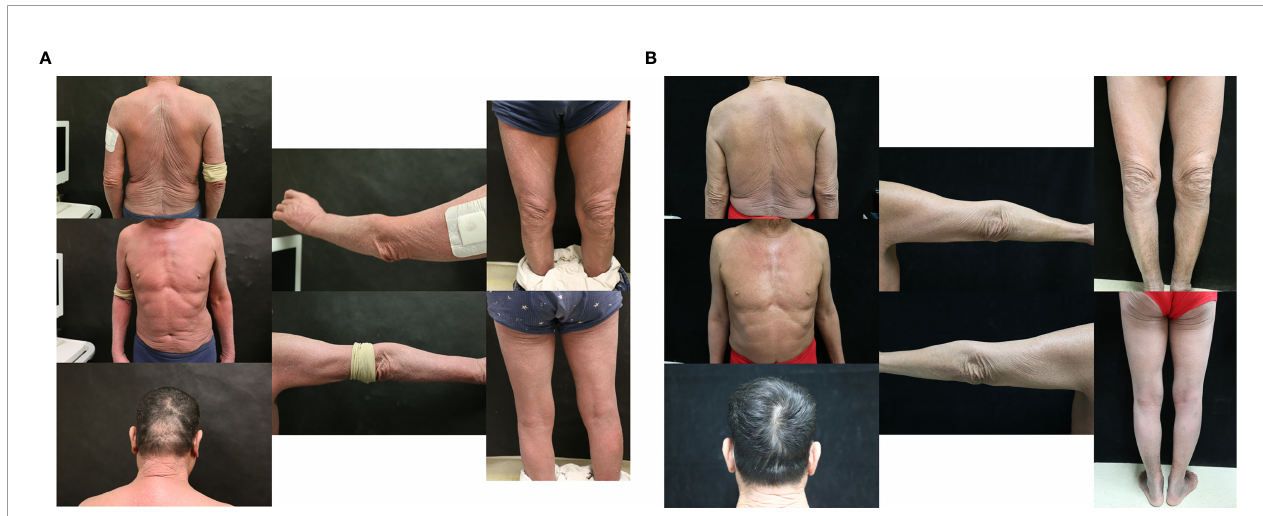
FIGURE 1 | (A) Skin symptoms of patient 1 before sintilimab and chidamide combination treatment. (B) Skin symptoms of patient 1 after 6 cycles of combination